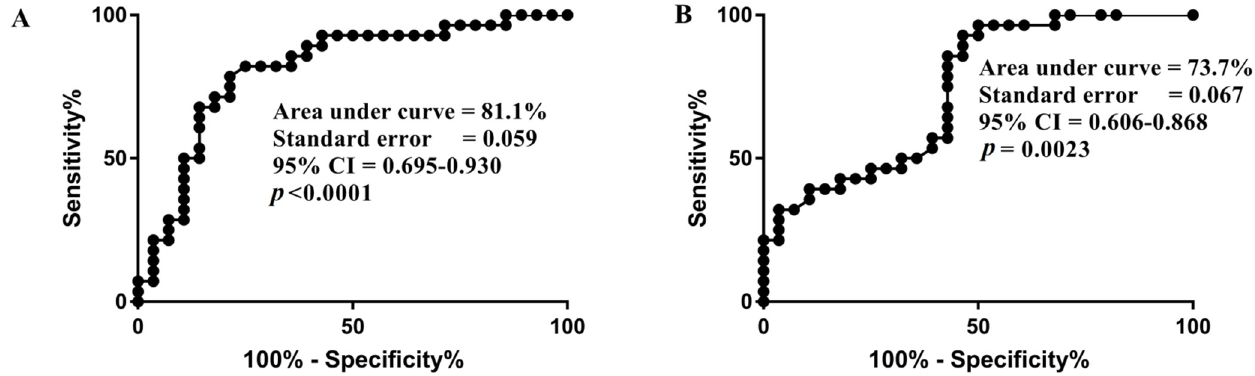
Figure 3. Receiver operating curve based on ( A ) IL-6 and ( B ) IL-10 levels in survived severe cases and fatal cases. 216